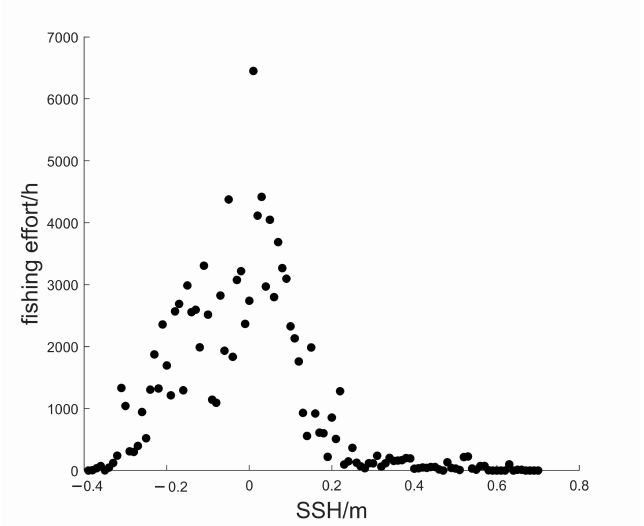
Figure 6. Scatter plot for the relationship between fishing effort and SSH.